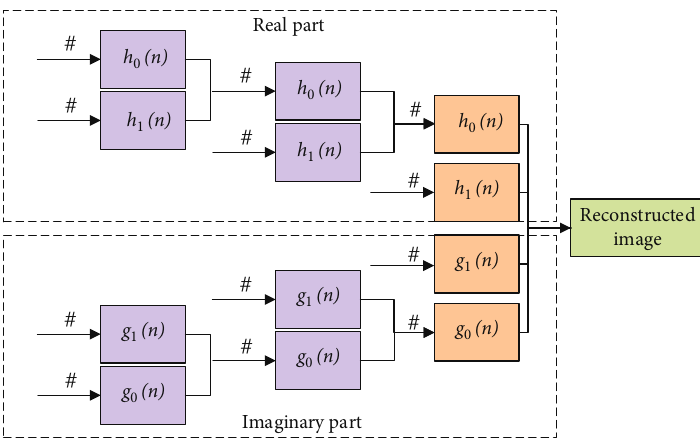
Figure 4: Schematic diagram of the reconstruction process of the one-dimensional DTCWT